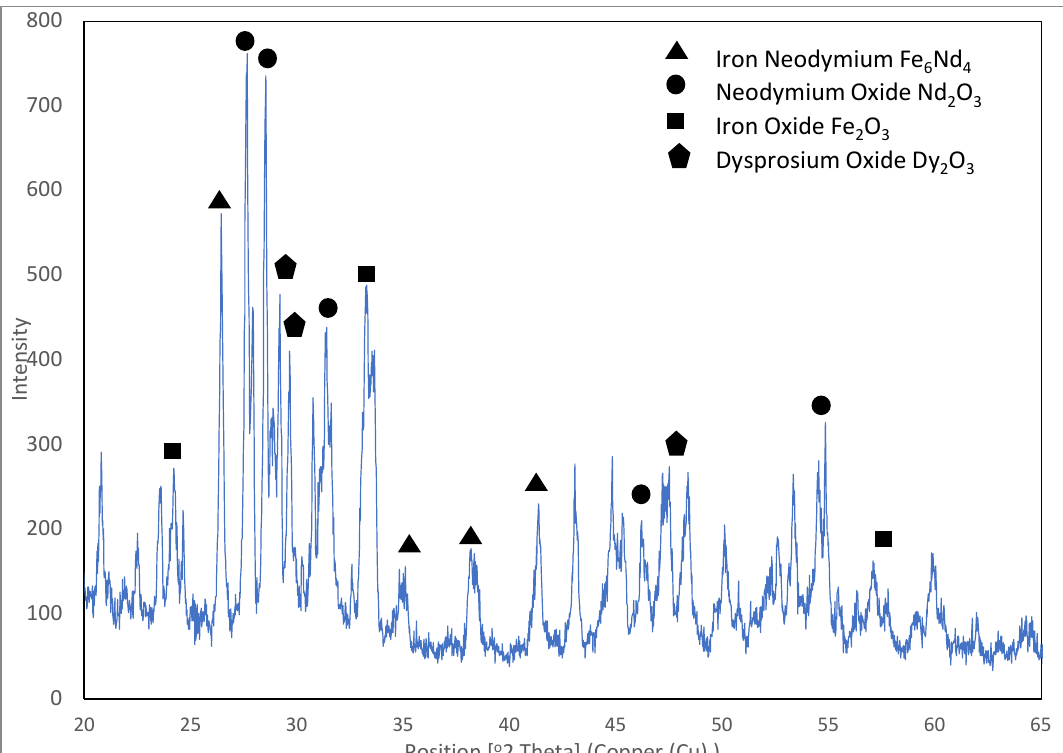
Figure 7. XRD analysis of slag phase from experiment V3 . Fe-separation represents the mechanical separation of metallic iron from the created slag. Generally, slag was separated by metallic iron from the formed mixture. Based on Table 7, the separation efficiency in the metallic phase amounts of 98.1%, 98.9%, and 97.5% for Nd, Pr, and Dy at 1500 ◦ C, respectively. The excellent separation efficiency is also confirmed in V2 at 1400 ◦ C. Separation efficiency in the metallic phase amounts of 96.9%, 97.2%, and 95.8% for Nd, Pr, and Dy at 1400 ◦ C, respectively. The reduced efficiency of the REE-separation during reductive smelting is a consequence of the reduction of the melting temperature from 1500 ◦ C to 1400 ◦